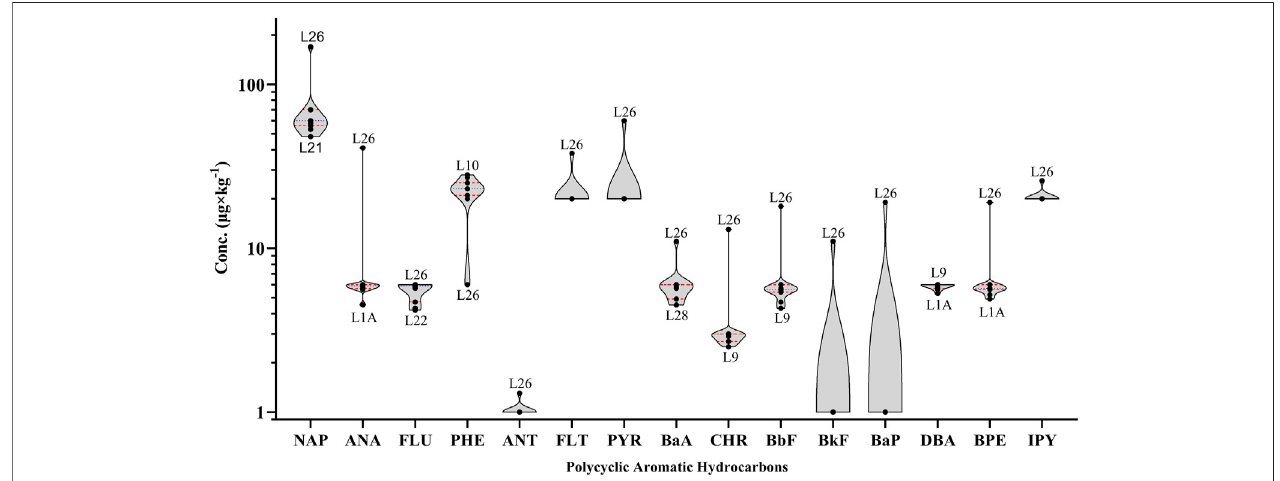
FIGURE 2 | PAHs concentrations in soils, μ g × kg − 1